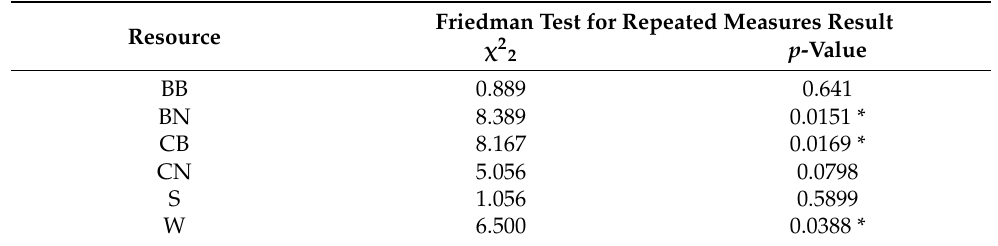
Table 1. Friedman test for repeated measures results, showing a significant different in use of the resources BN, CB, and W between time periods. Significant results are represented by an asterisk.